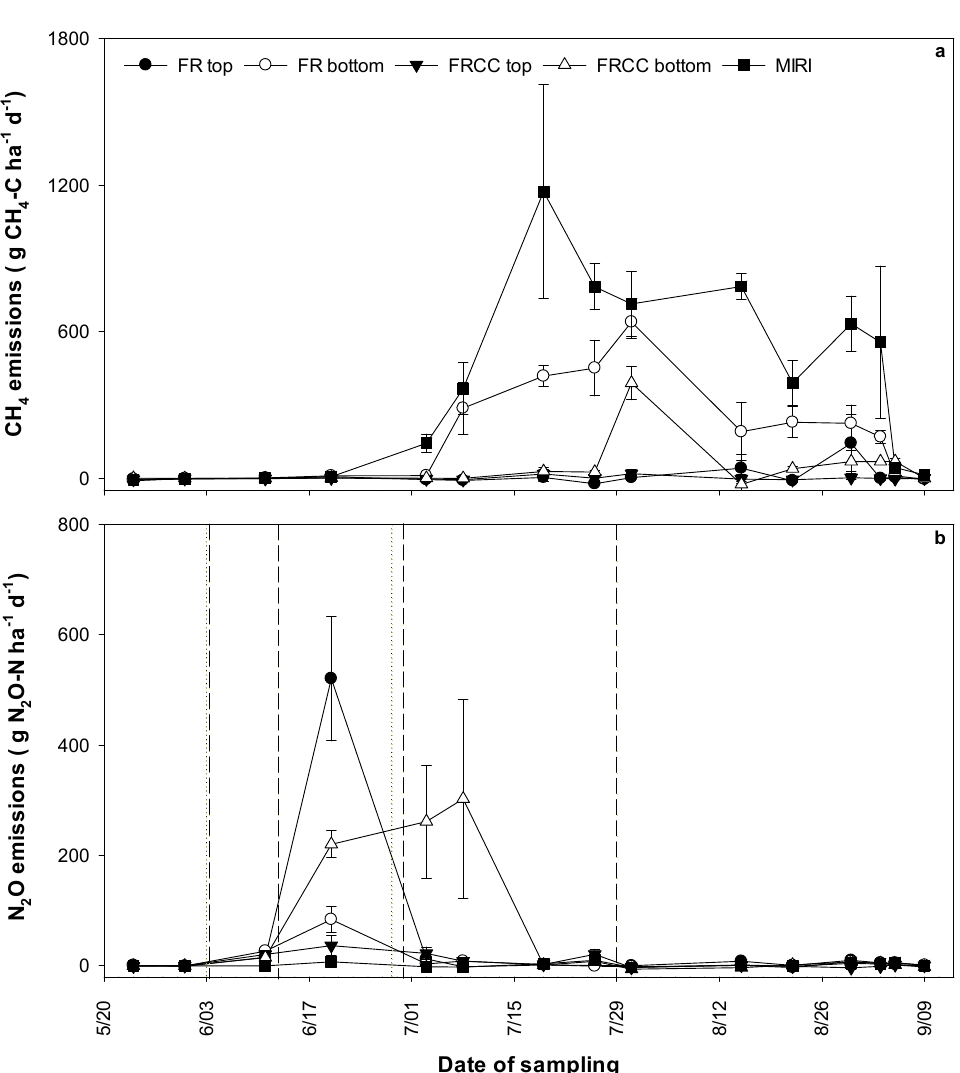
Figure 5. ( a ) Methane and ( b ) nitrous oxide emissions from the top and bottom sections of a furrow-irrigated rice field (FR), a furrow-irrigated rice with winter cover crop field (FRCC) and a multiple-inlet rice irrigation field (MIRI) during the 2019 growing season. Data shown are mean ± standard error ( n = 5). Short and long dotted lines represent N fertilizations made to the MIRI and furrow-irrigated rice fields, respectively. Fertilizer was applied only to the top of the FRCC field on 07/29/2019.